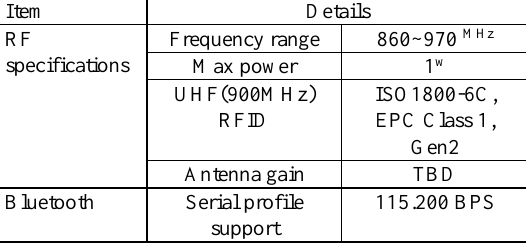
Table 2. DOTR 900 UHF RFID reader specification